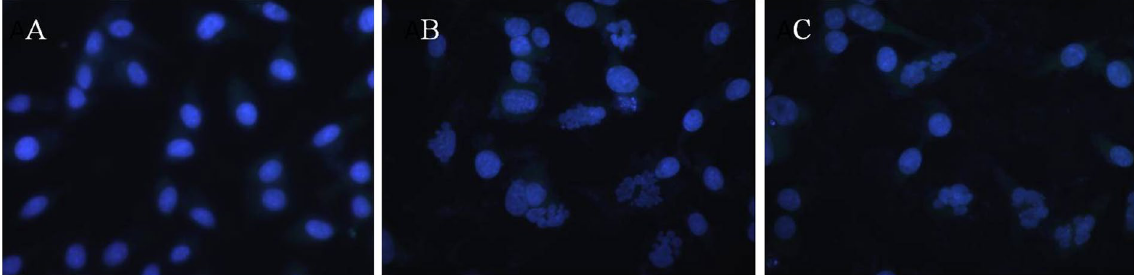
Figure 8. Fluorescent microscopy of MDA-MB-231 cells with DAPI staining. ( A ) Untreated cells as control, ( B ) treated cells with SNPs, and ( C ) treated cells with ASNPs.